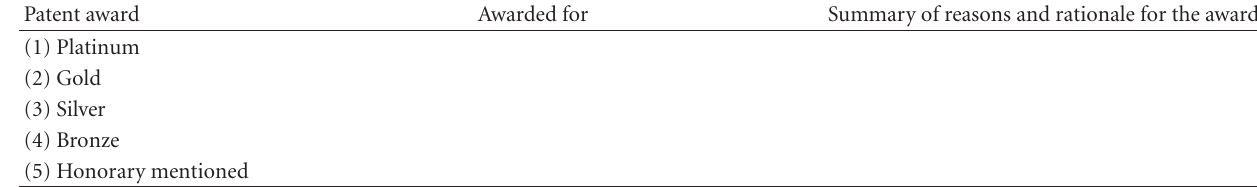
Table 5: Re-design patent awards and the reason behind they being